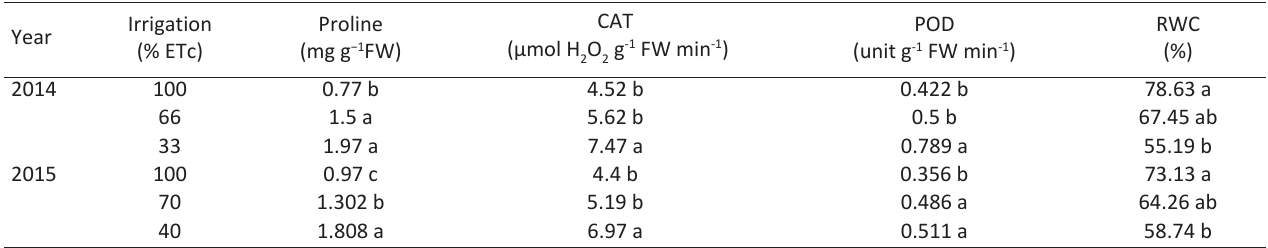
I 33 , I4 40 , I 66 , I 70 and I 100 represent the irrigation treatments that received 33, 40, 66, 70 and 100% of ETc, respectively. Values are the average of 10 observation of each replication per irrigation level. Within each column, values followed by the same letters are not signifi- cantly different at